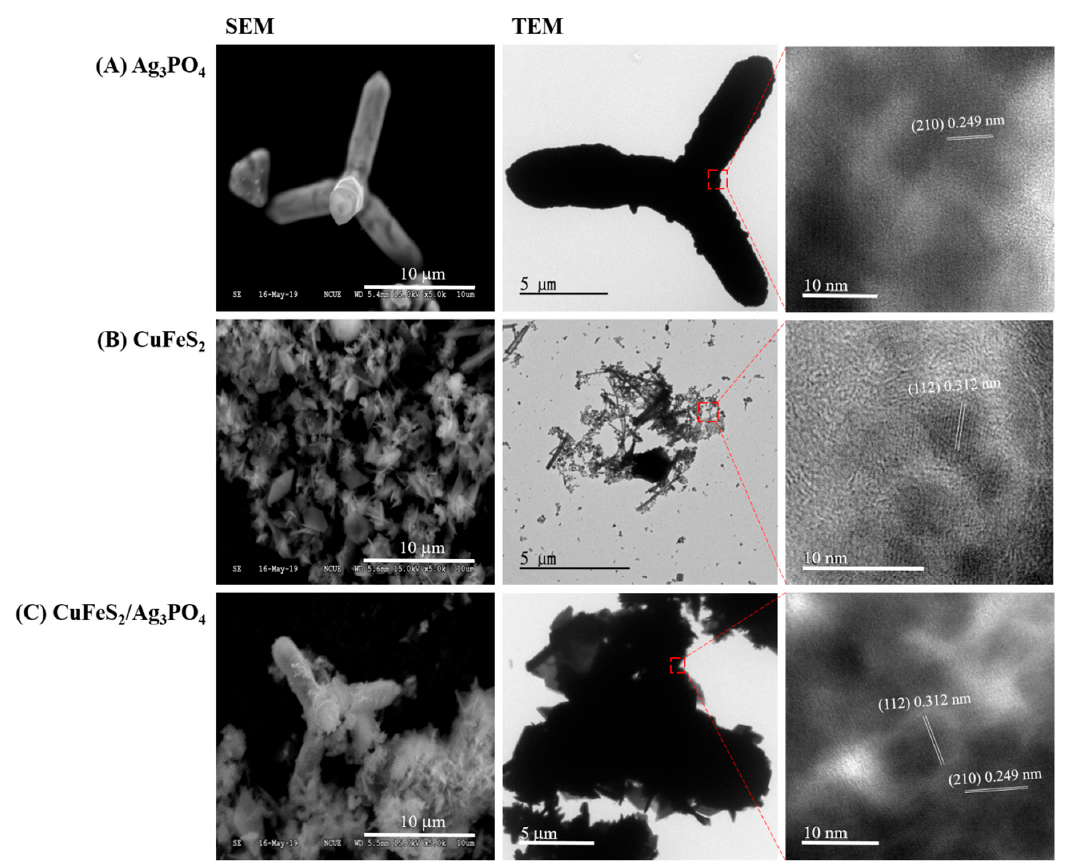
Figure 1. SEM and TEM images of ( A ) Ag 3 PO 4 ; ( B ) CuFeS 2 ; and ( C ) CuFeS 2 /Ag 3 PO 4 composites.